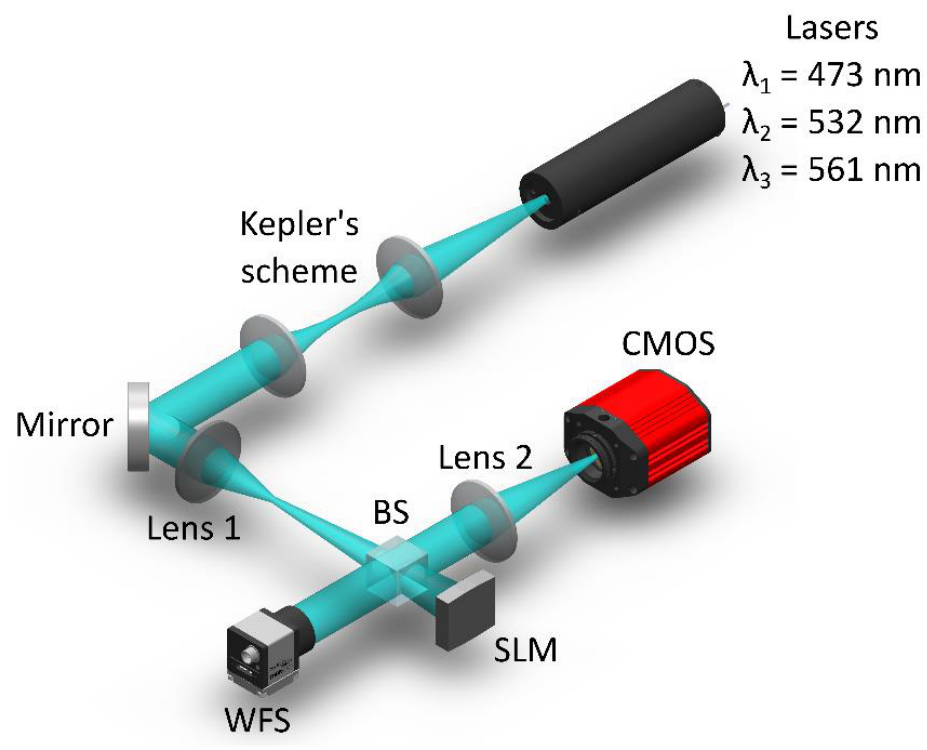
Figure 3. Simplified experimental scheme.